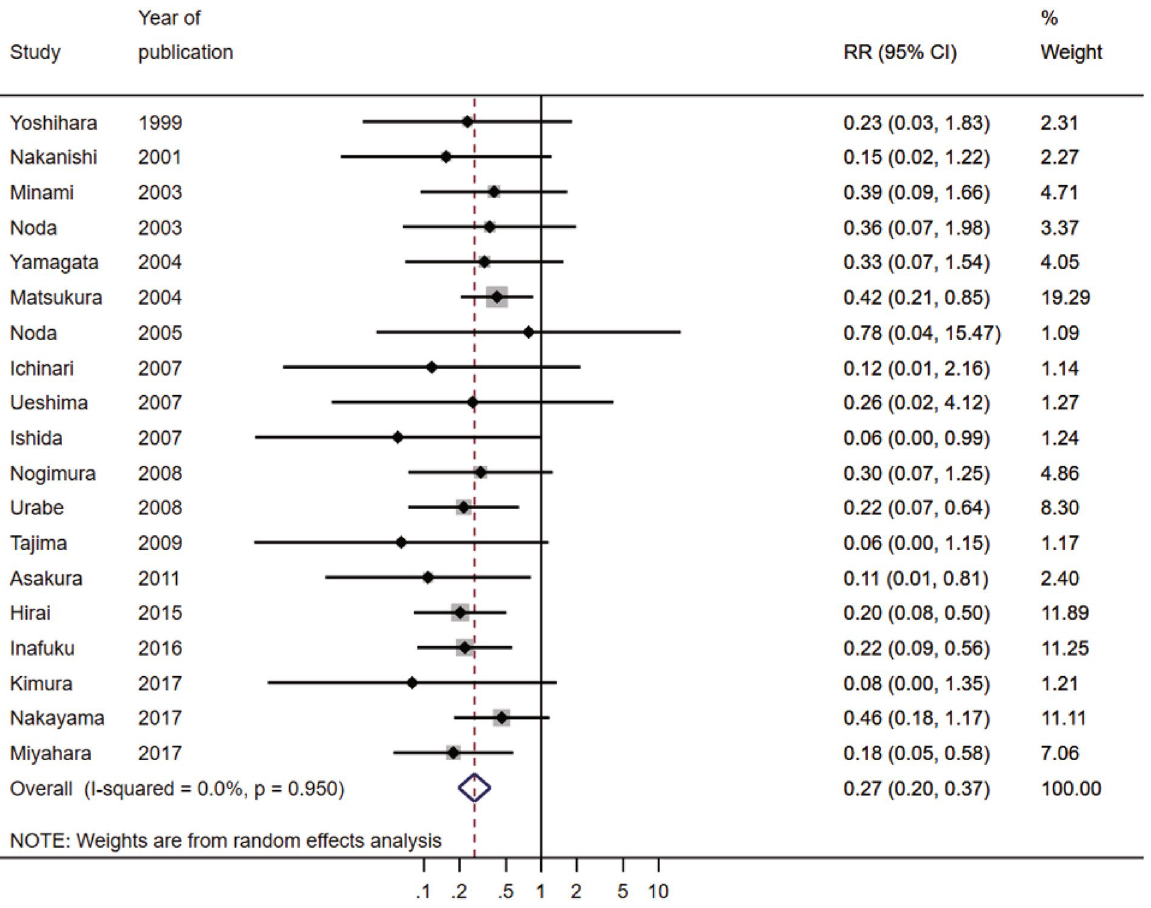
Figure 2. Forest plot of the risk ratio for recurrence. CI confidence interval, RR risk ratio.